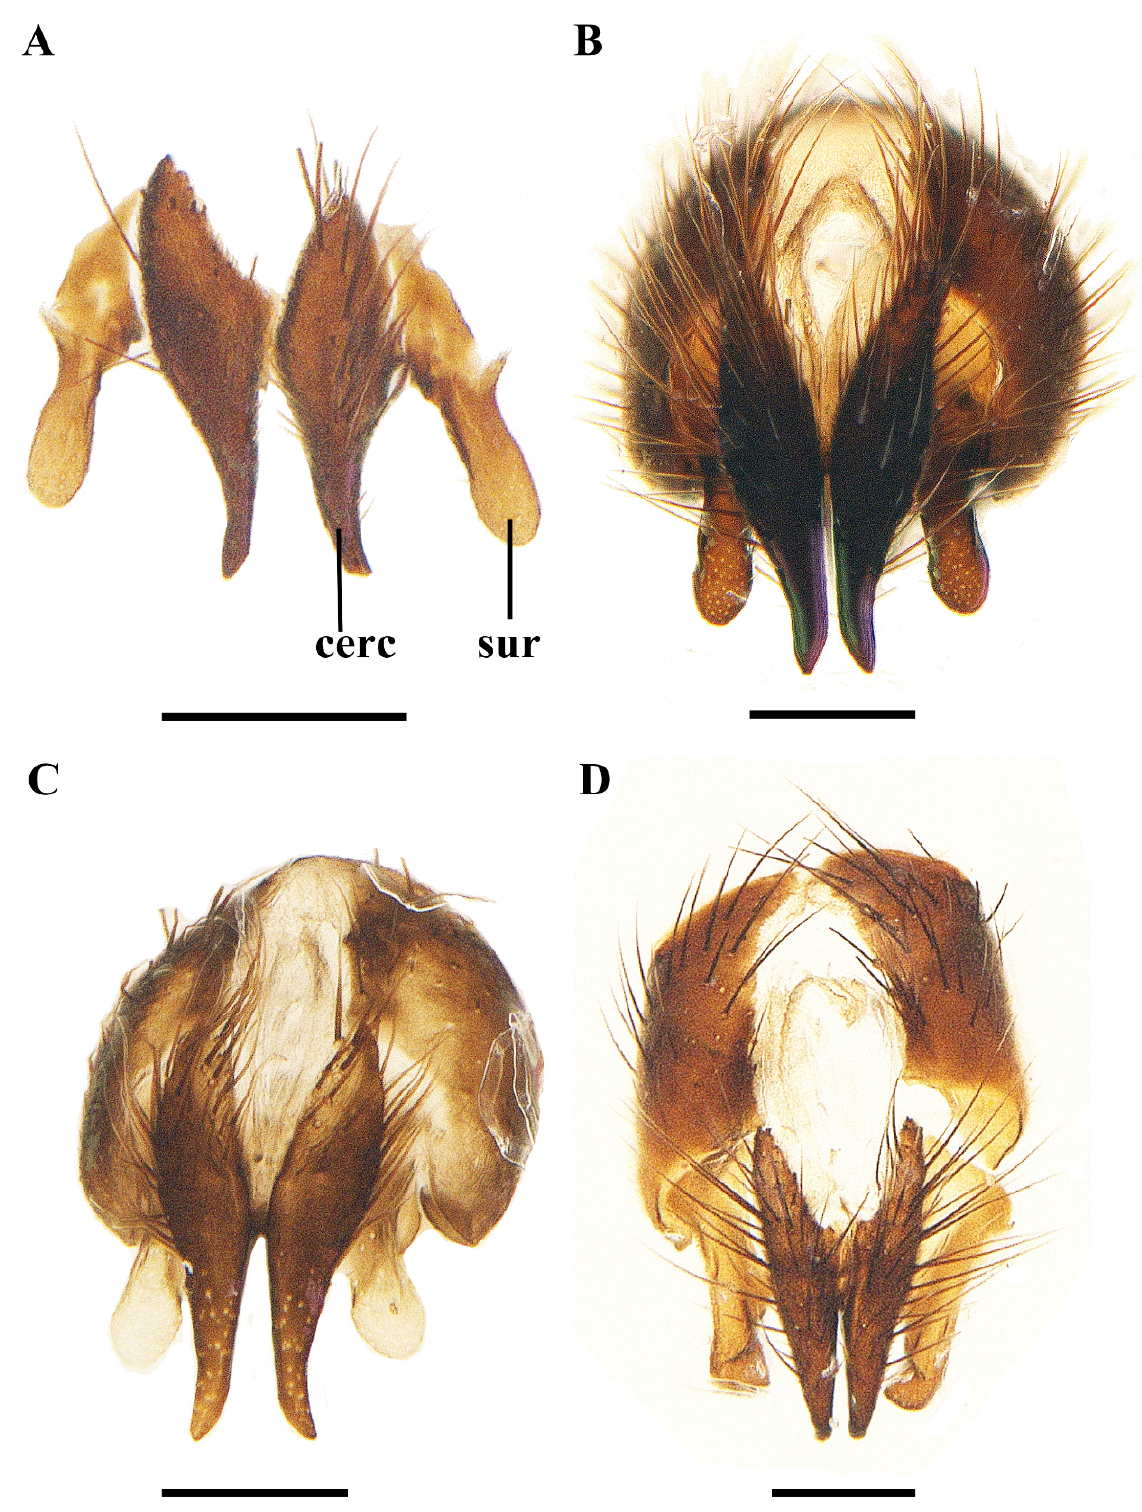
Figure 7. Caudal view of male terminalia of Macquartia spp. ( A ) M. brunneisquama sp. nov. ( B ) M. chinensis sp. nov. ( C ) M. flavipedicel sp. nov. ( D ) M. flavifemorata sp. nov. Scale bar = 0.2 mm. (Abbreviations: cerc = cercus; sur = surstylus.)